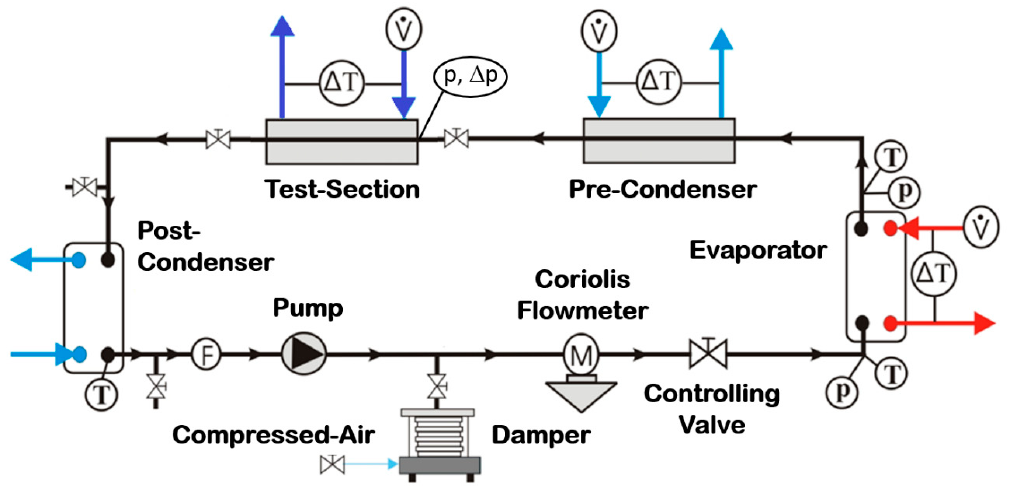
Figure 1. Schematic of the test rig.